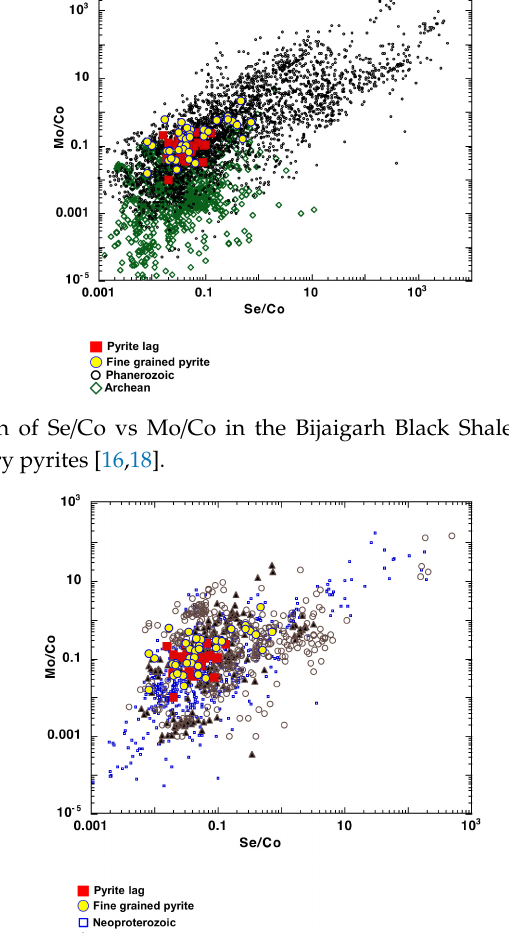
Figure 13. Comparison of Se / Co vs Mo / Co in the Bijaigarh Black Shale unit with Proterozoic pyrites